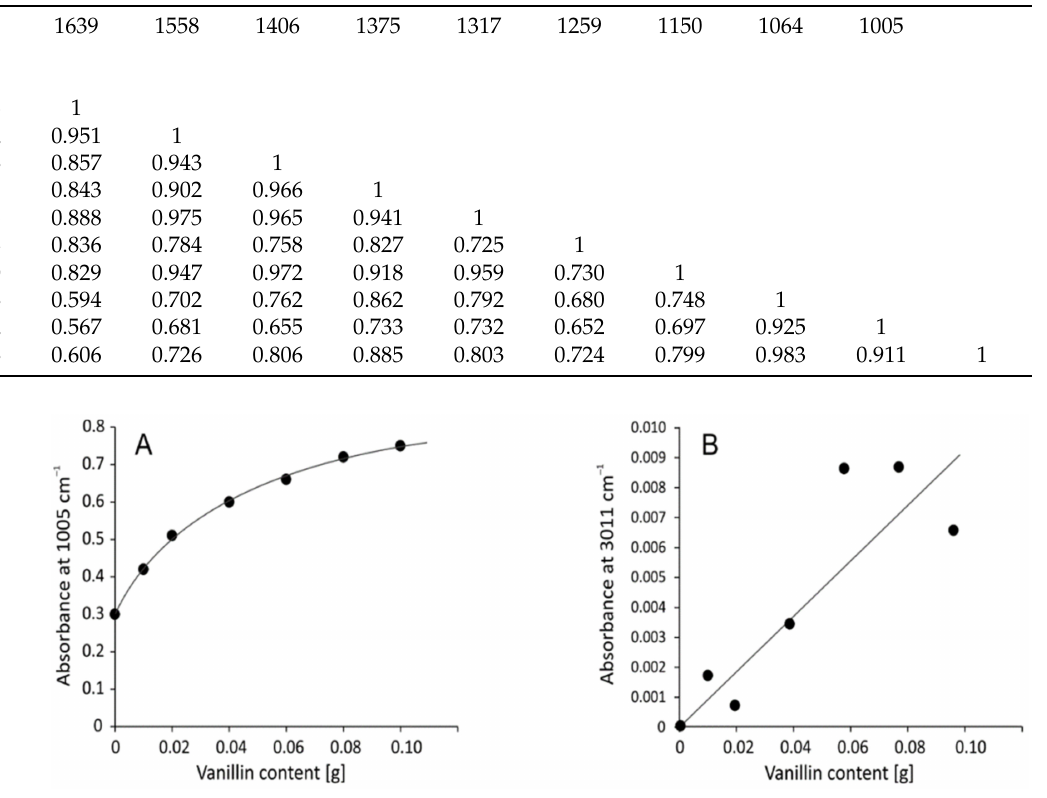
Table 2. Correlation matrix of FTIR peaks and vanillin content.